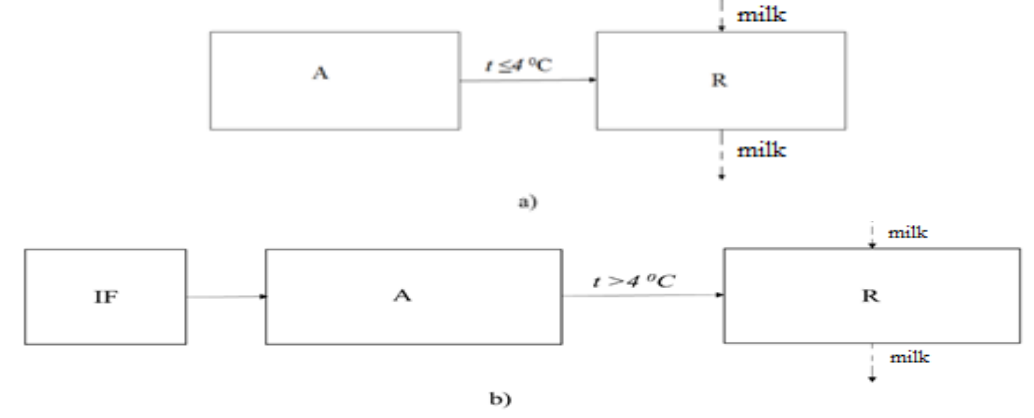
Figure 13. Milk chilling by using natural (a) and artificial cold (b).